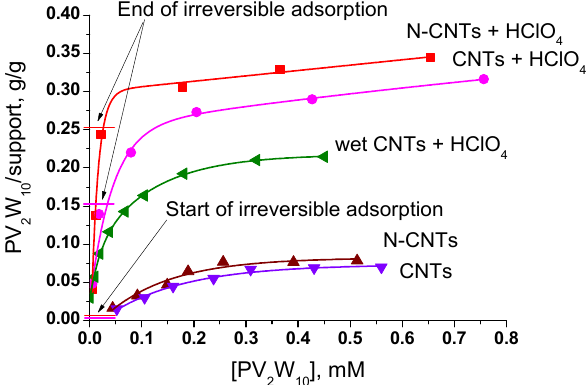
Figure 3. Adsorption of γ -PV 2 W 10 on CNTs and N-CNTs (4.8 at. % N) from CH 3 CN at 25 °C (HClO 4 additives, one equiv to POM). Adapted with permission from ref. [100] Evtushok et al. Highly efficient catalysts based on divanadium-substituted polyoxometalate and N-doped carbon nanotubes for selective oxidation of alkylphenols ACS Catalysis 2018 , 8 , 1297–1307. Copyright 2018 American Chemical Society.